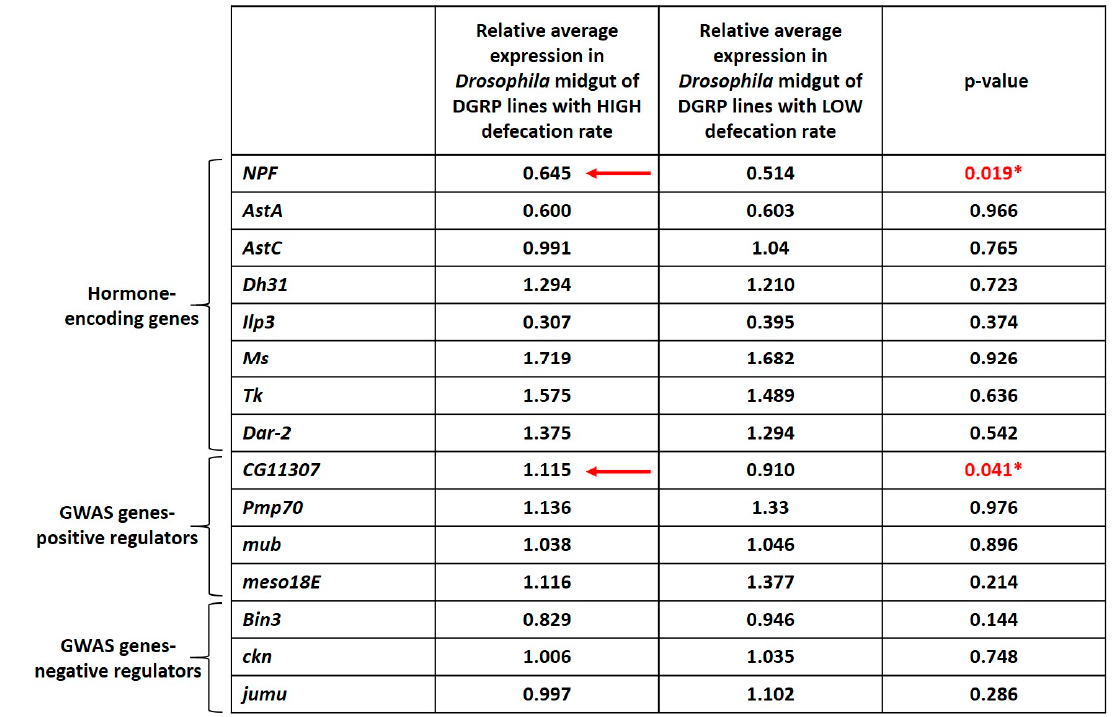
Figure 5. High defecation rate DGRP lines exhibit higher midgut expression of NPF and CG11307 , indicated by horizontal red arrows. Midgut expression of hormone encoding genes ( AstA , AstC , Dh31 , Ilp3 , Ms , Tk , Dar-2 ) and GWAS-identified genes considered either positive regulators of the defecation rate, ( Pmp70 , mub , meso18E ) or negative regulators ( Bin3 , ckn and jumu ), in eight DGRP lines displaying high (25208, 28128, 25201, 28180, 28171, 28123, 29658, 28244) versus eight DGRP lines displaying low (28206, 28182, 28153, 28246, 25745, 25189, 28242, 28150) defecation rates. For each of the 16 DGRP lines the mean expression value of six biological replicates per gene was calculated and normalized to that of the strain OR6, and then used to find the relative average expression per group of eight high and eight low defecation rate lines. Statistical analysis was performed using the Mann–Whitney U test. Statistical significance ( p < 0.05) is indicated with asterisks and red font for NPF and CG11307 .